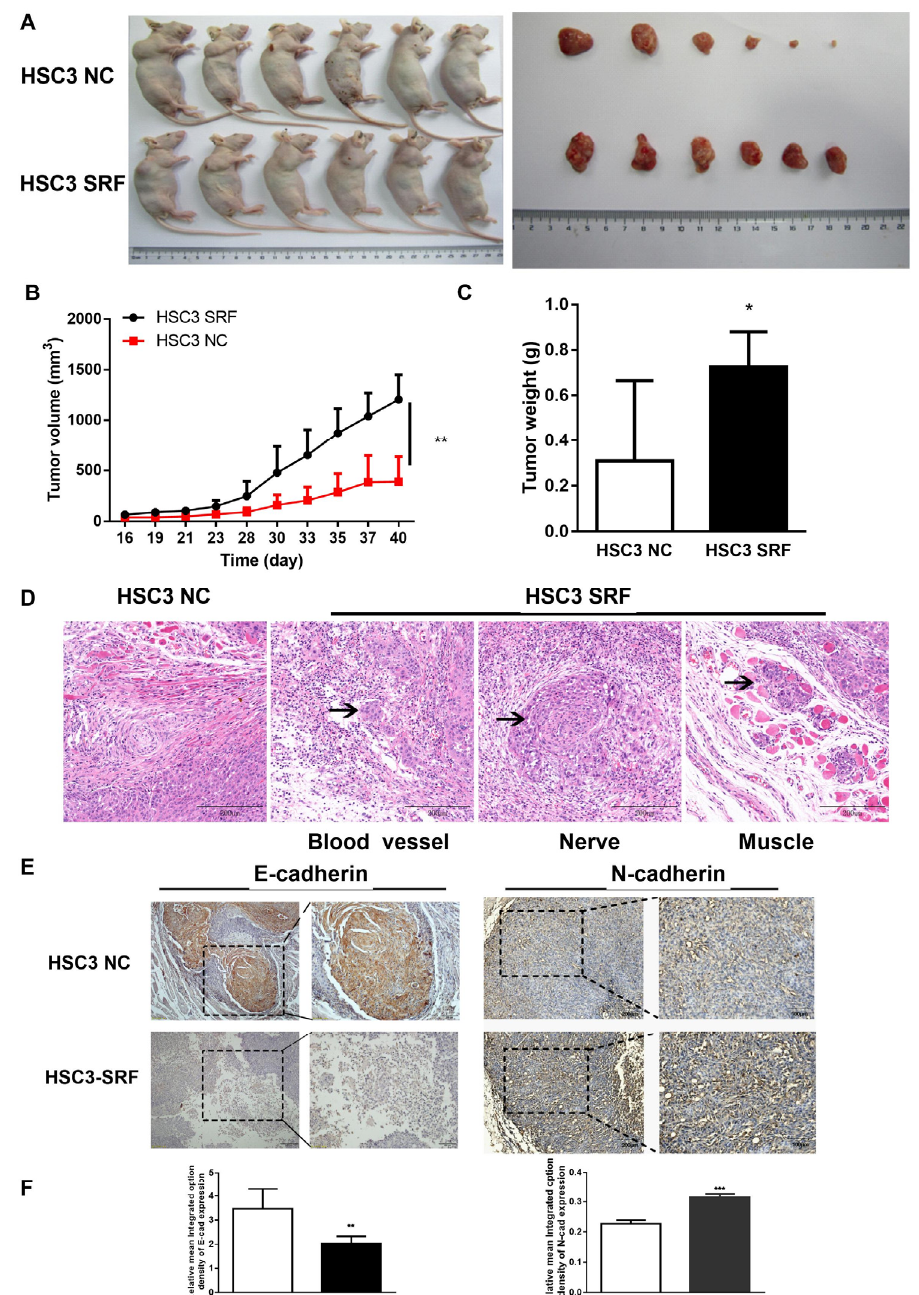
Figure 4. SRF overexpression promotes OSCC tumorigenesis in vivo. Xenografted nude mice ( n = 6/group) were injected with HSC3 cells stably overexpressing SRF. The mice were euthanized, and tumors were excised from nude mice 40 days after HSC-3 cell injection ( A ). Tumor volumes were measured using calipers ( B ), and tumors were weighed at the end of the experiment ( C ). Statistical data were derived from three independent measurements and are shown as means ± SDs. Infiltration of HSC-3-SRF tumor cells ( D ). Representative immunohistochemical images of E-cadherin and N-cadherin expression in samples from HSC-3-NC and HSC-3-SRF cells ( E ). The scale bar is shown in lower-right corner. Mean optical density of E-cadherin and N-cadherin in tumor samples from HSC-3-NC and HSC-3-SRF cells ( F ). * p < 0.05, ** p < 0.01, *** p < 0.001, tumor samples from HSC-3-NC cells compared with HSC-3-SRF cells. NC, negative control; OSCC, oral squamous cell carcinoma; SRF, serum response factor.